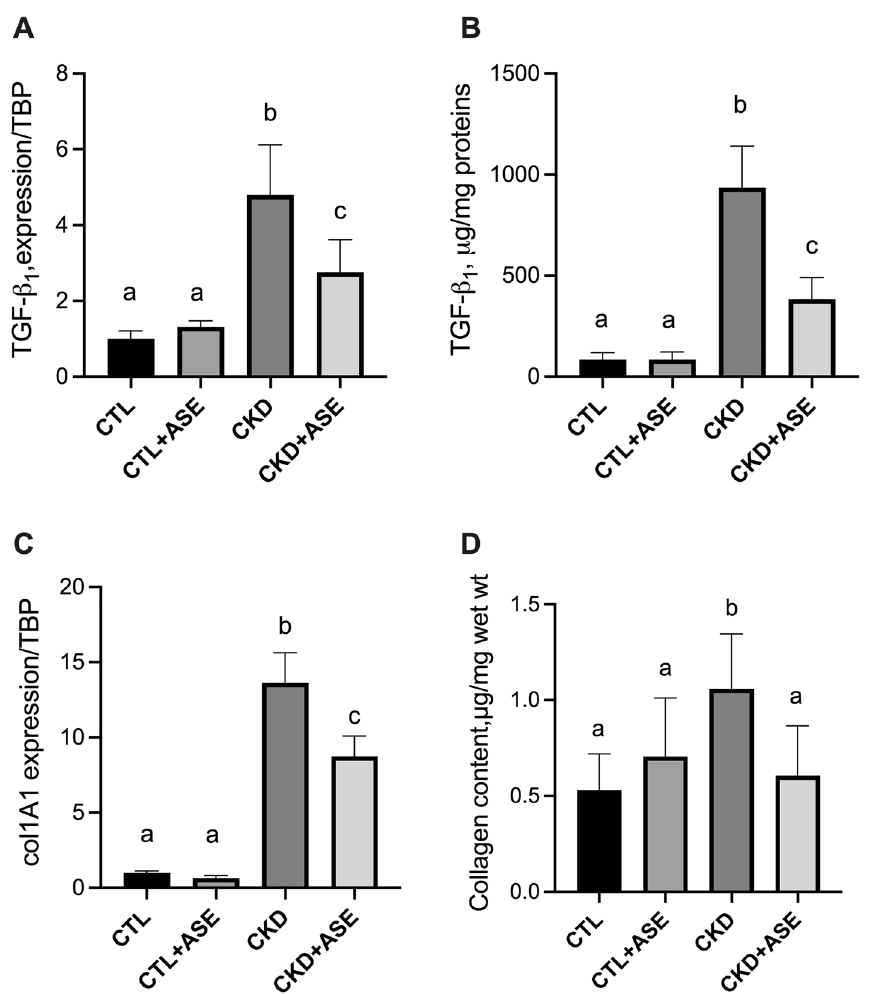
Figure 4. Biomarkers of kidney fibrosis. ( A ) Gene expression of transforming growth factor β1(TGF-β1), ( B ) immunoassay of TGF-β1 protein in kidney lysate. ( C ) Gene expression of collagen 1 type 1 (col1a1). ( D ) Collagen tissue content in the kidney estimated by hydroxyproline assay. TATA box binding protein (TBP) was used as reference gene to normalize all the gene expression data. Data are expressed as mean ± SD for n = 8–10 animals in each group. Significant differences were determined by two-way ANOVA followed by Tukey’s multiple comparison test. Different letters indicate a significant difference between groups at the P < 0.05